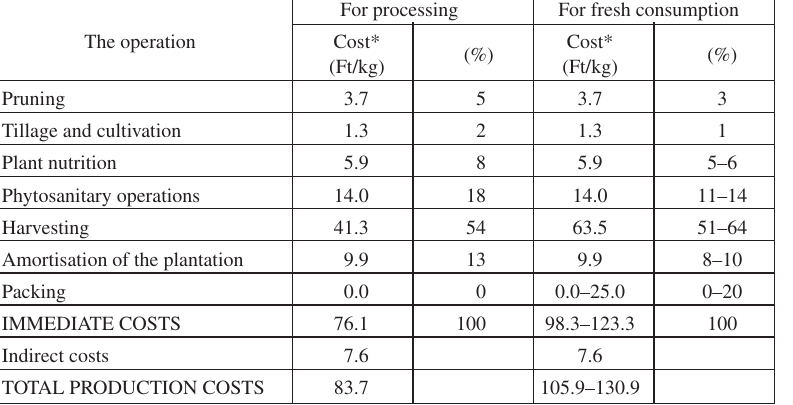
Table 1. Productions costs of 1 kg sour cherry for processing and for fresh consumption For